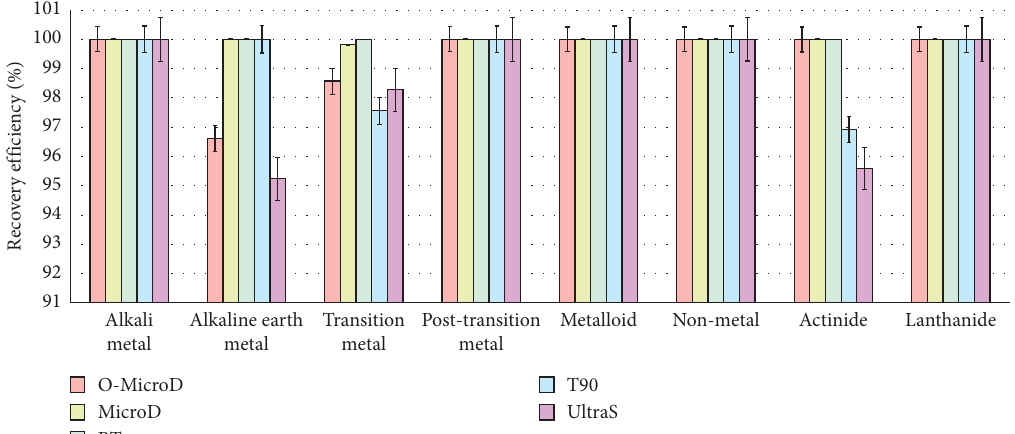
Figure 1: Te bar chart represents the recovery efciency (%) of eight diferent element classes across fve diferent digestion methods for the standard solution.